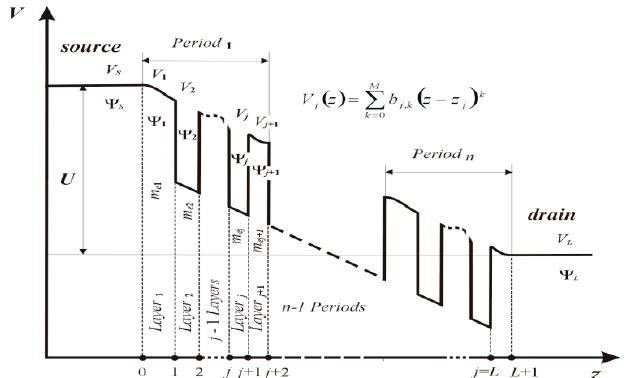
Figure 3. Concepts of polynomial approximation of the potential in the QCL structure. In each superlattice layer, a constant value of the effective mass of the electron and a variable potential described by the polynomial function V j ( z ) were assumed.